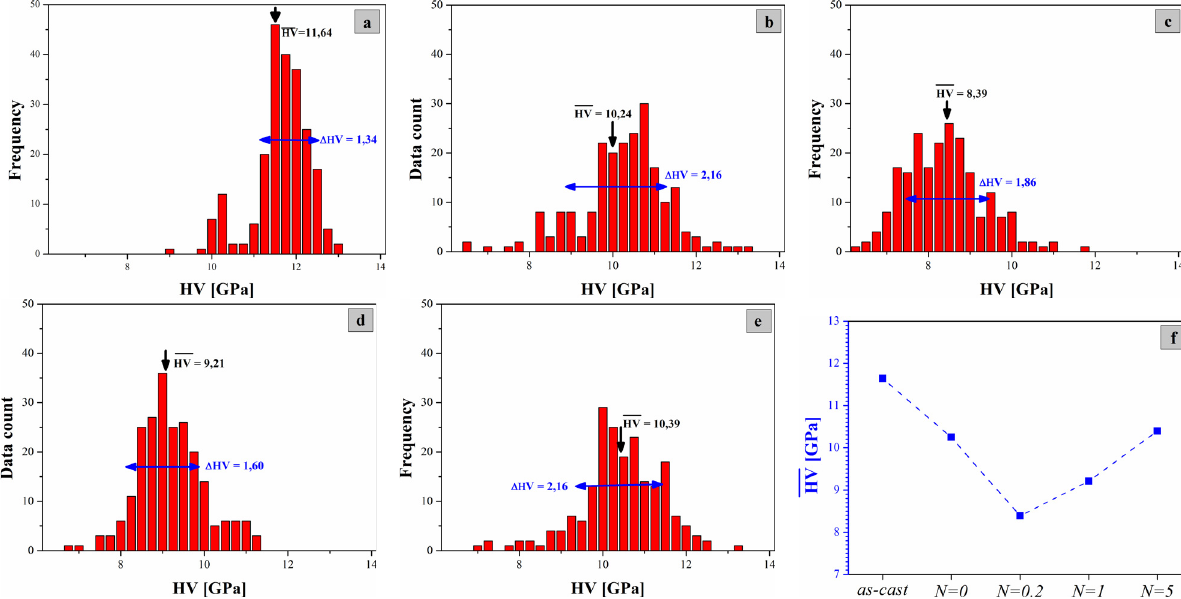
Figure 9: Distributions of the nanohardness values measured on the (a) as-cast, (b) N=0 compressed, (c) N=0.2, (d) N=1 and (e) N=5 HPT samples with the indicated averages and full widths of the distributions. (f) Variation of the average hardness for the different